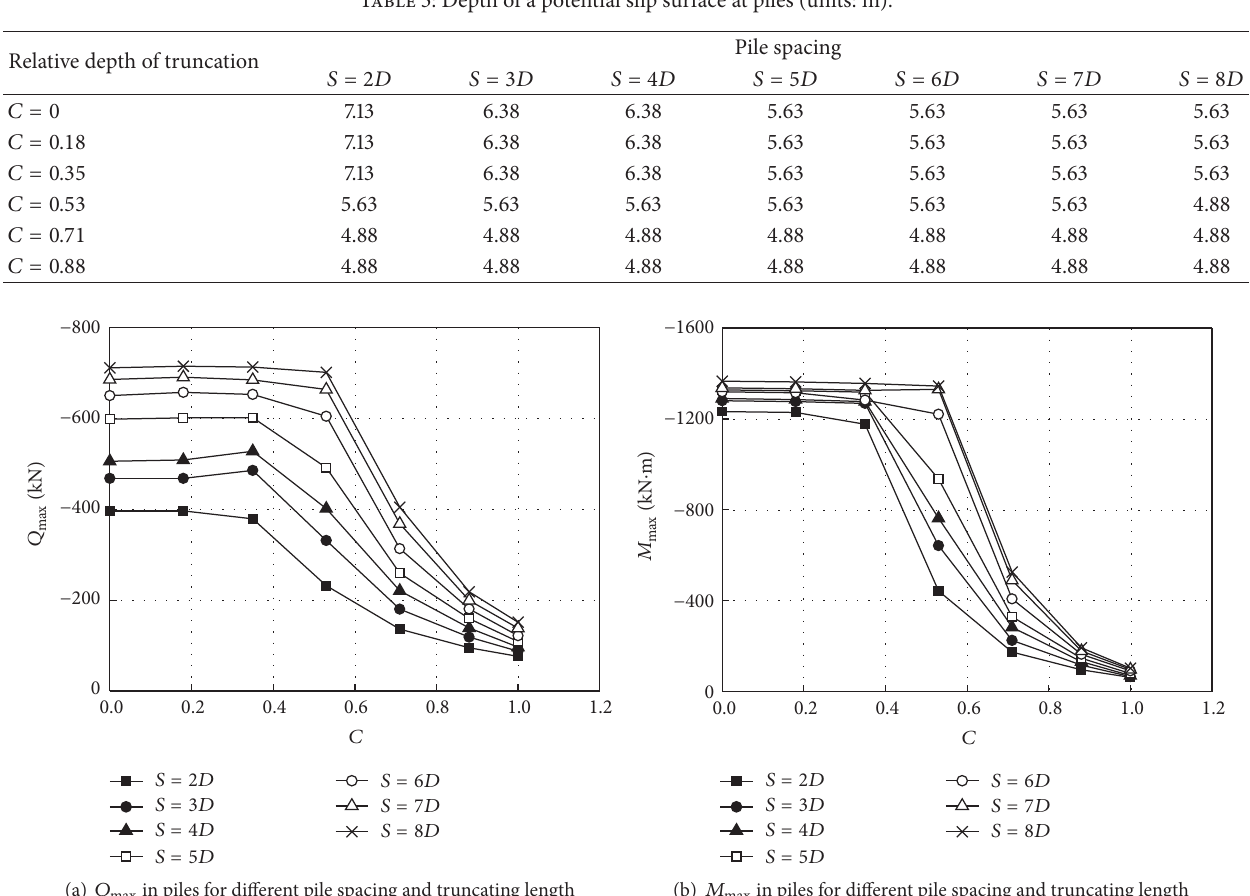
Table 3: Depth of a potential slip surface at piles (units: m).